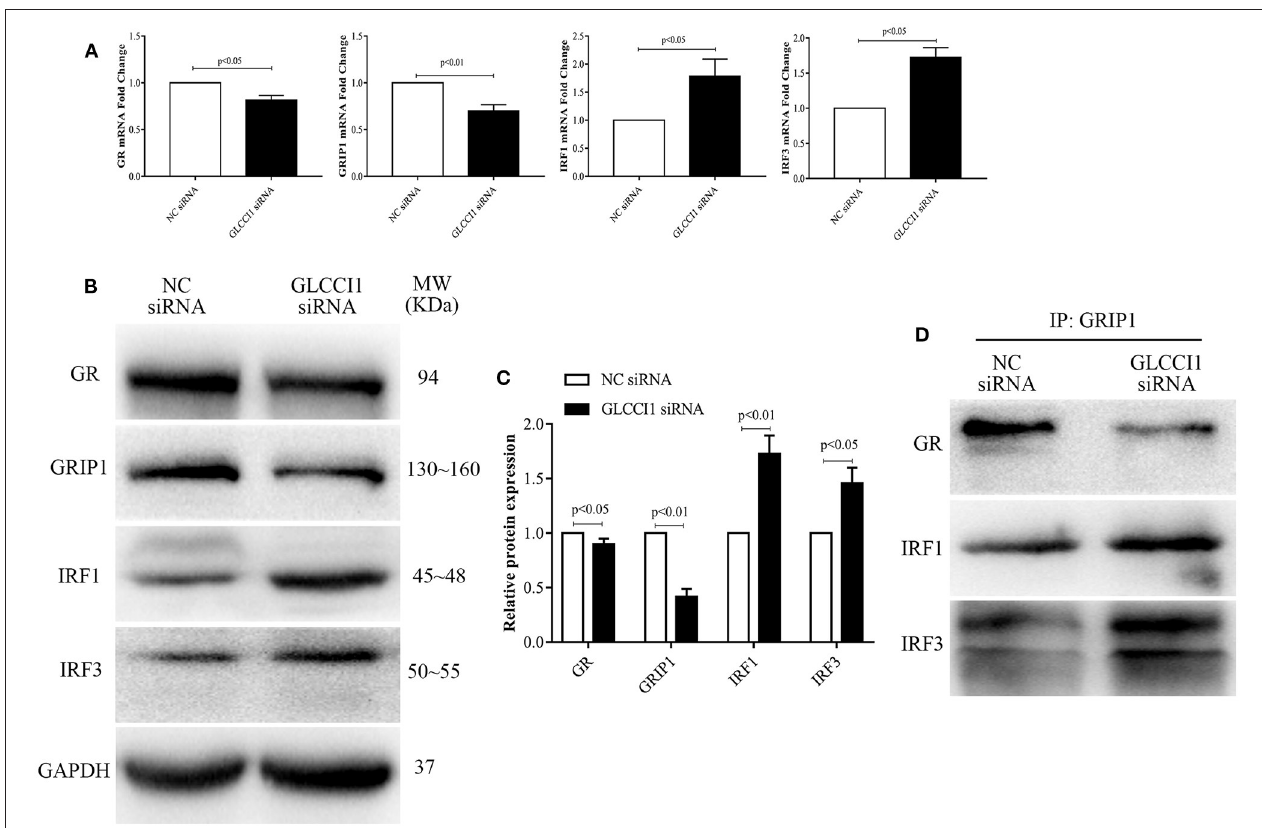
FIGURE 5 | GLCCI1 heightens the binding of IRF1 and IRF3 with GRIP1 and reduces GR and GRIP1 binding in A549 cells. A549 cells were treated with OVA and Dex in the presence and absence of GLCCI1 siRNA. (A) RT-PCR analysis of GR, GRIP1, IRF1, and IRF3 mRNA expression. Representative images of protein expression (B) and relative protein levels (C) of GR, GRIP1, IRF1, and IRF3. (D) Anti-GRIP1 antibody was used to capture GR, IRF1, and IRF3 to detect the individual binding of GRIP1 with GR, IRF1, and IRF3. Data are presented as means ± SEM of more than three independent experiments. Intergroup differences as determined by Student’s t